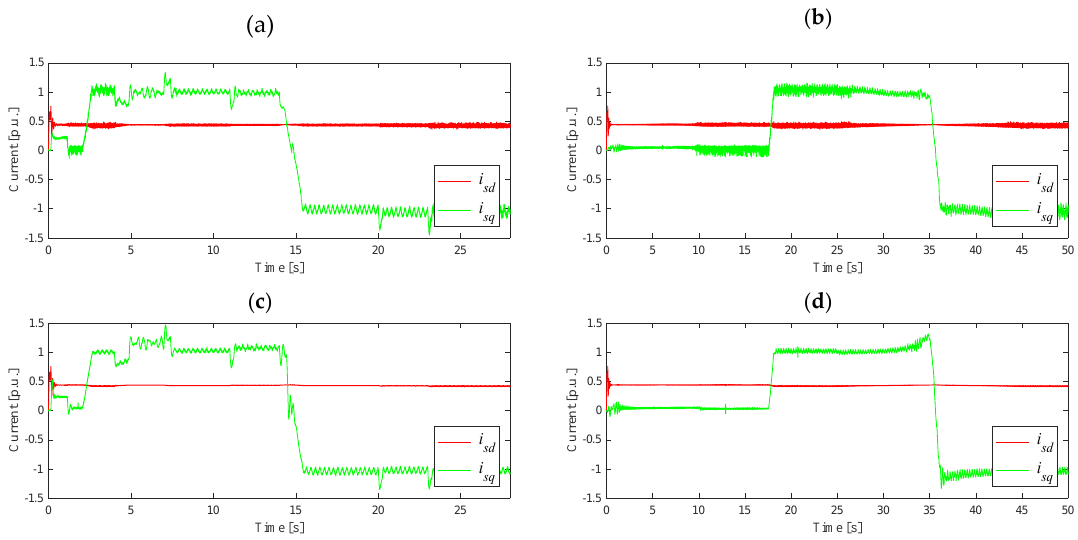
Figure 9. Waveforms of d – q components of the stator current for speed trajectories as seen in Figure 8a,b; measured currents (switch P in position 1) ( a , b ); estimated currents (switch P in position 2) ( c , d ).